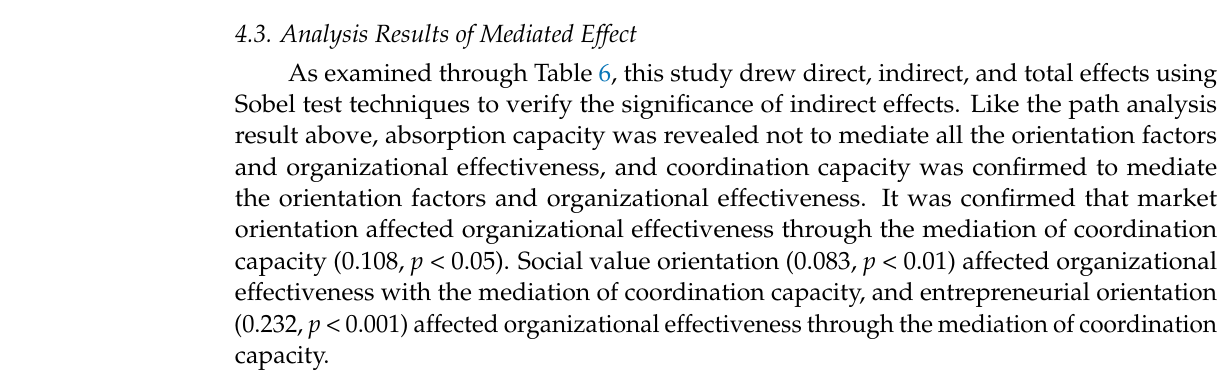
Table 6. Results of mediated